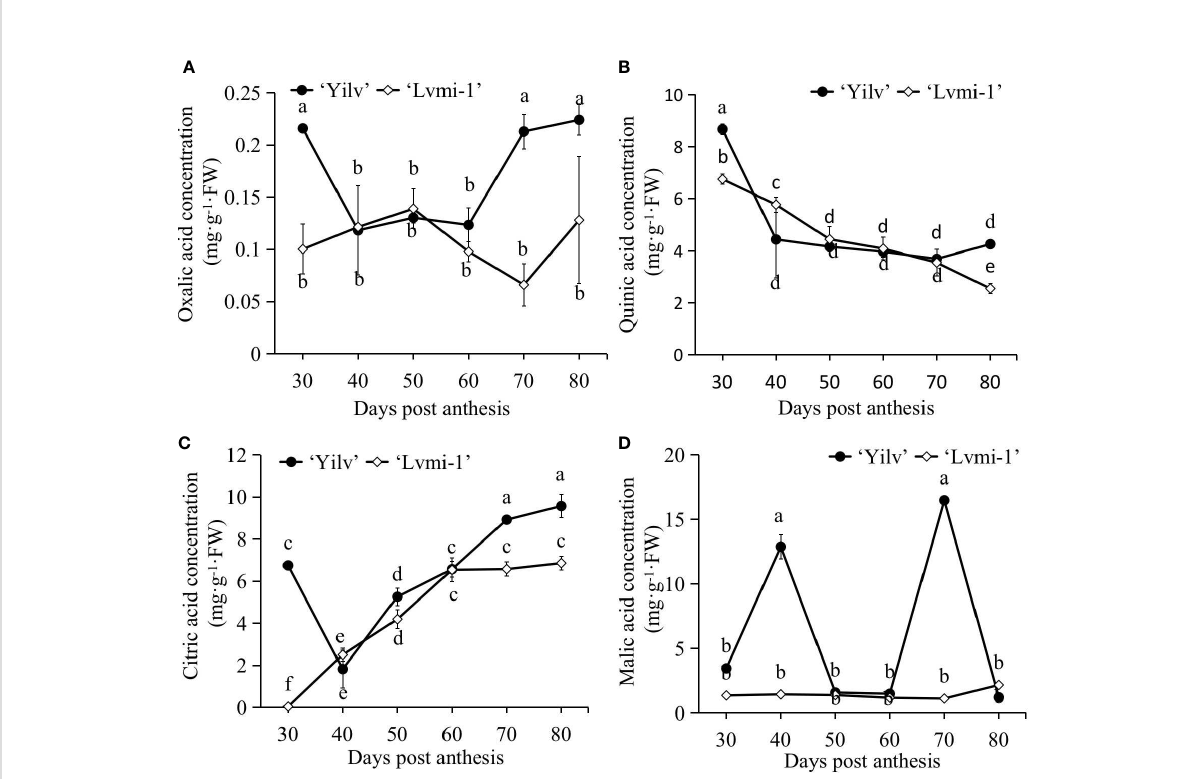
FIGURE 4 Changes of organic acid composition and content of ‘ Yilv ’ and ‘ Lvmi-1 ’ fruits during fruit development and maturity. (A) Oxalic acid content. (B) Quinic acid content. (C) Citric acid content. (D) Malic acid content. FW, fresh weight. Data were represented by the mean values ± standard deviation. Different letters indicated signi fi cant difference at the p ≤ 0.05